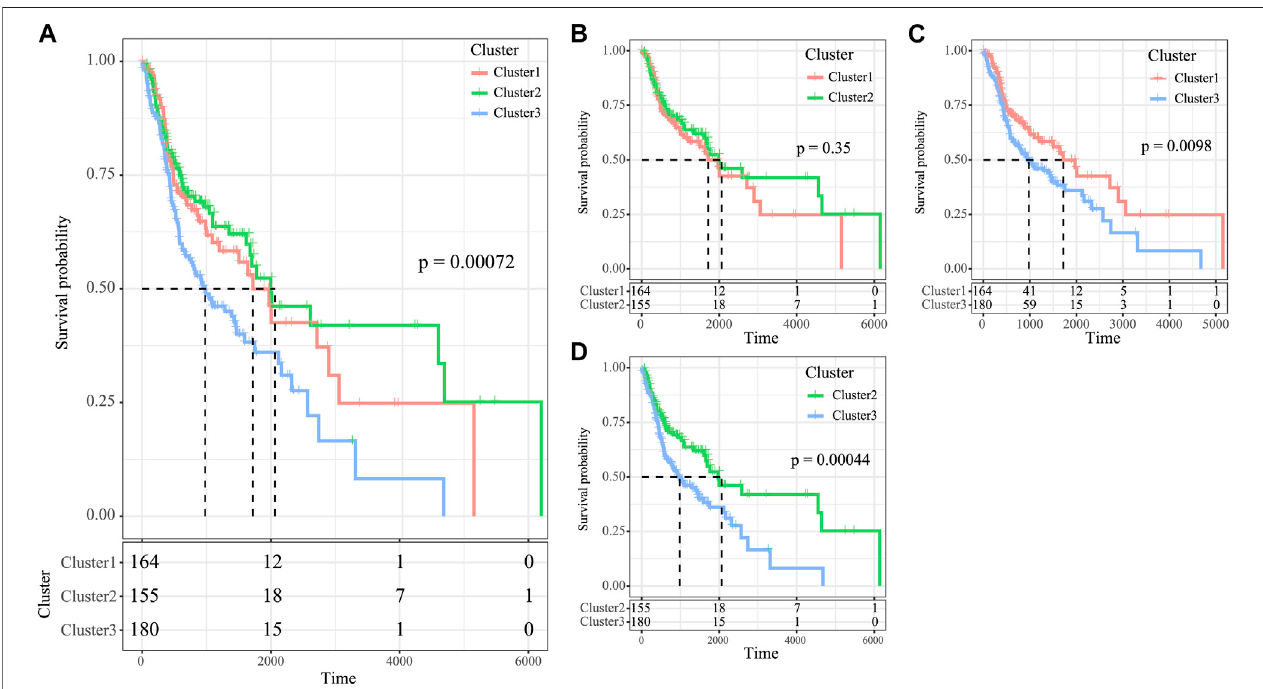
FIGURE5| Survivalanalysisofthe threeHNSCC subtypes. (A) KM curve ofOSprognosisofthree subtypes. (B) Prognosis difference KM curve ofC1and C2. (C) Prognosis difference KM curve of C1 and C3 (D) Prognosis difference KM curve of C2 and C3.